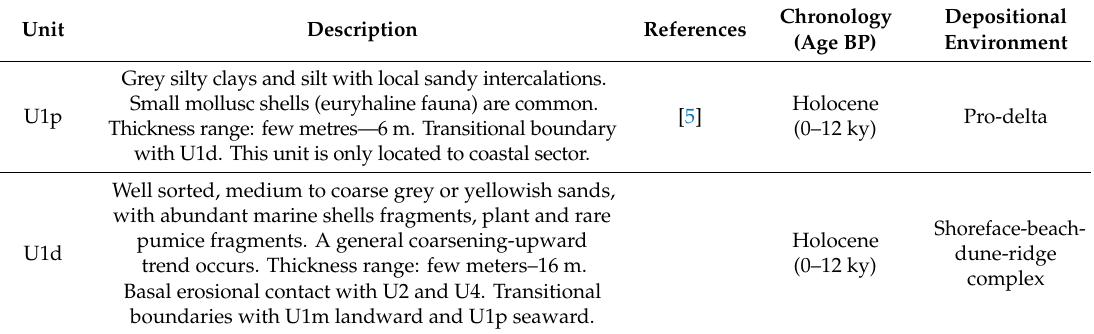
Table 1. Summarized description of the main lithostratigraphic units recognized by core data and environmental interpretation (ages from